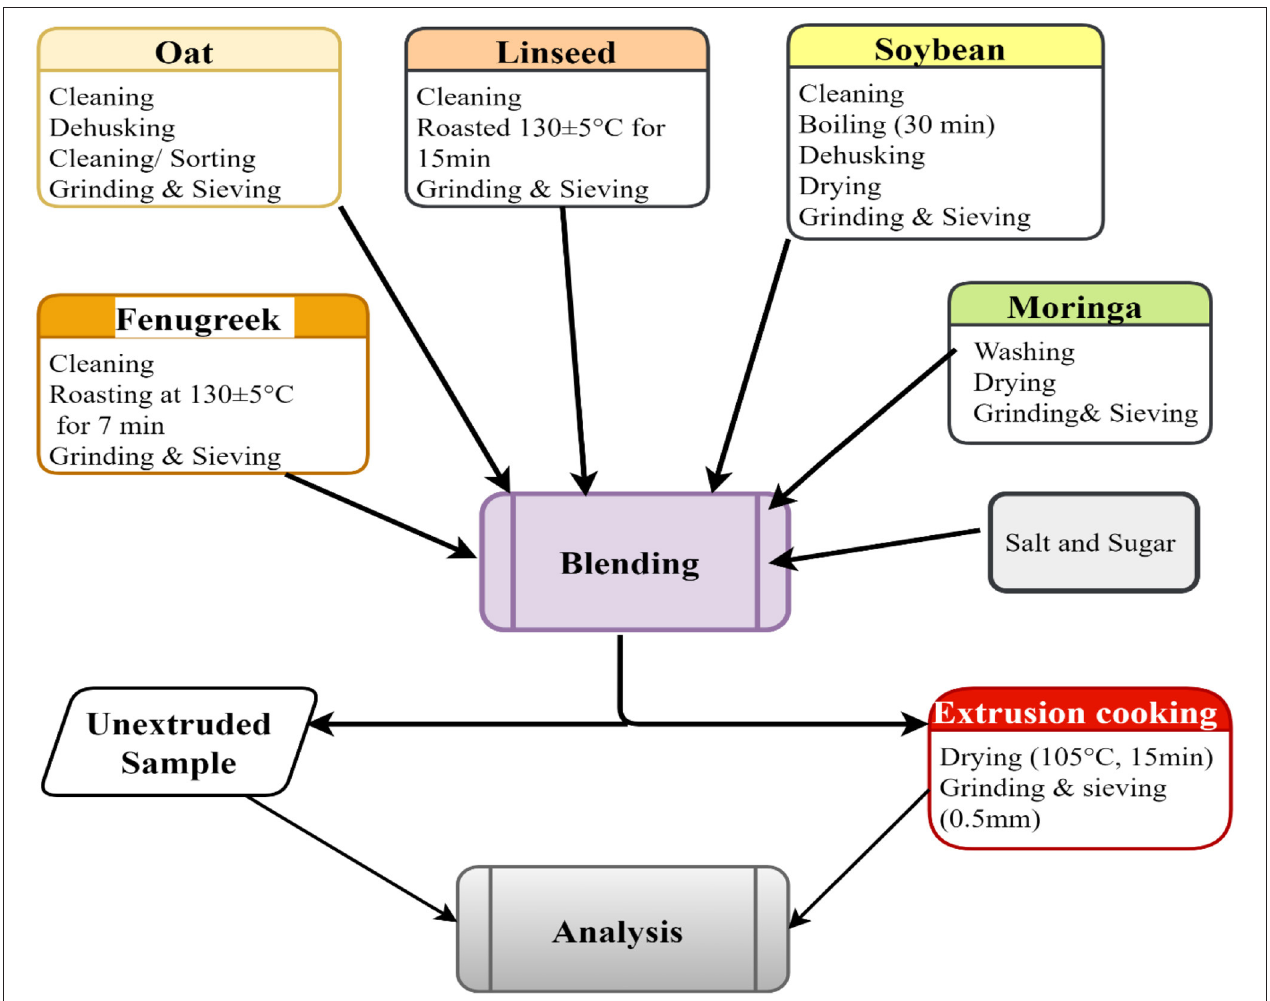
FIGURE 1 | Flow diagram of sample